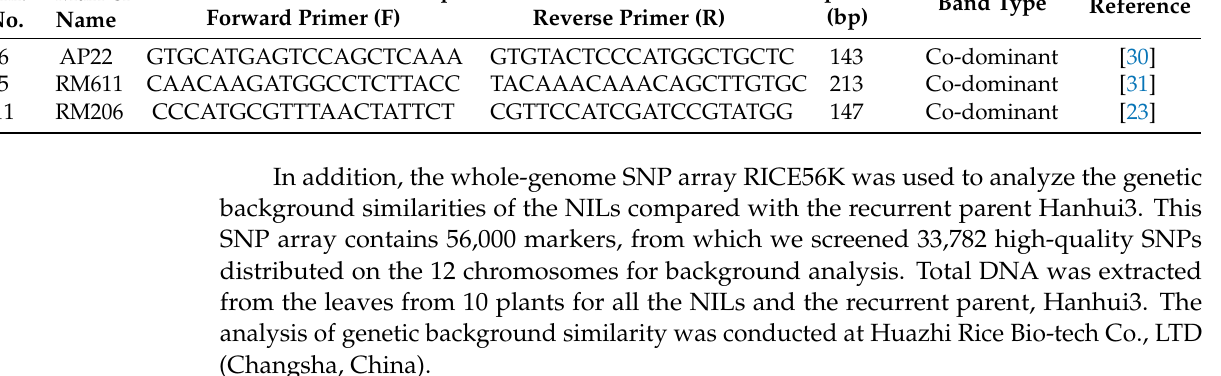
Table 1. Linked markers for foreground selection of Pi2 , xa5 , and Xa23